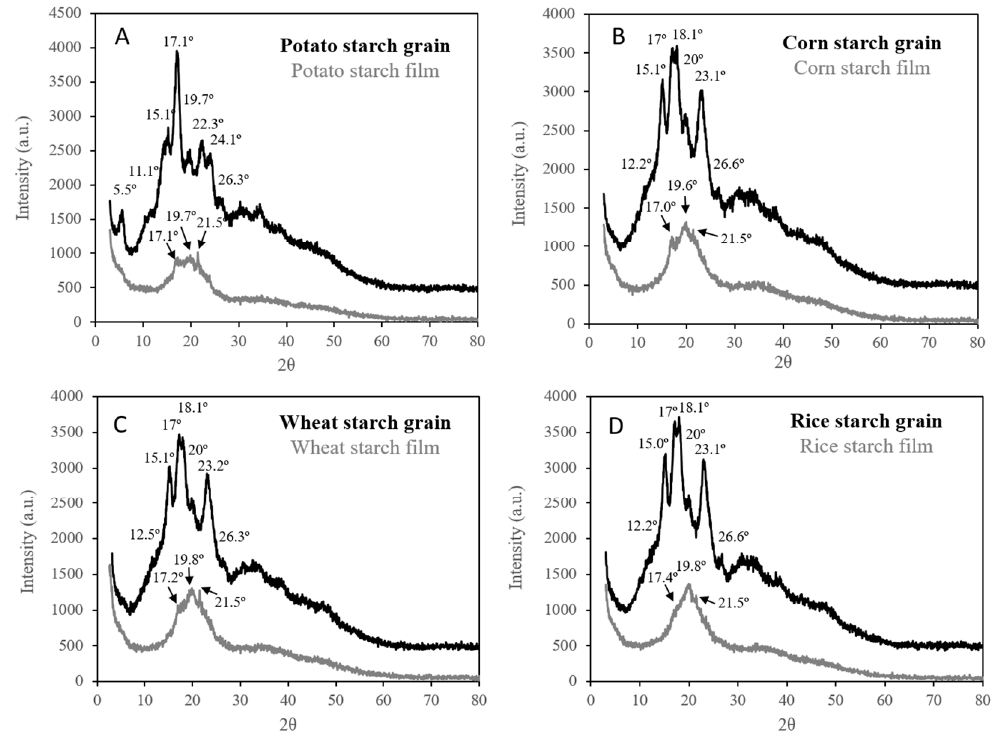
Figure 6. XRD of the starch grains and obtained films.